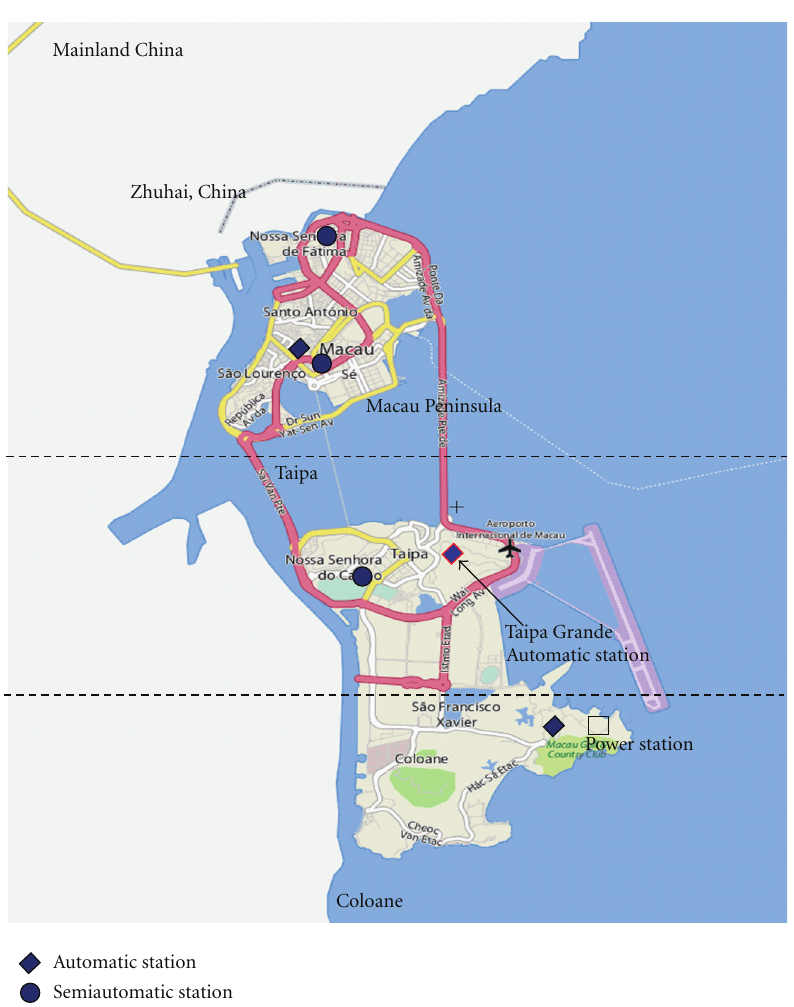
Figure 1: The three land zones of Macau and the location of the